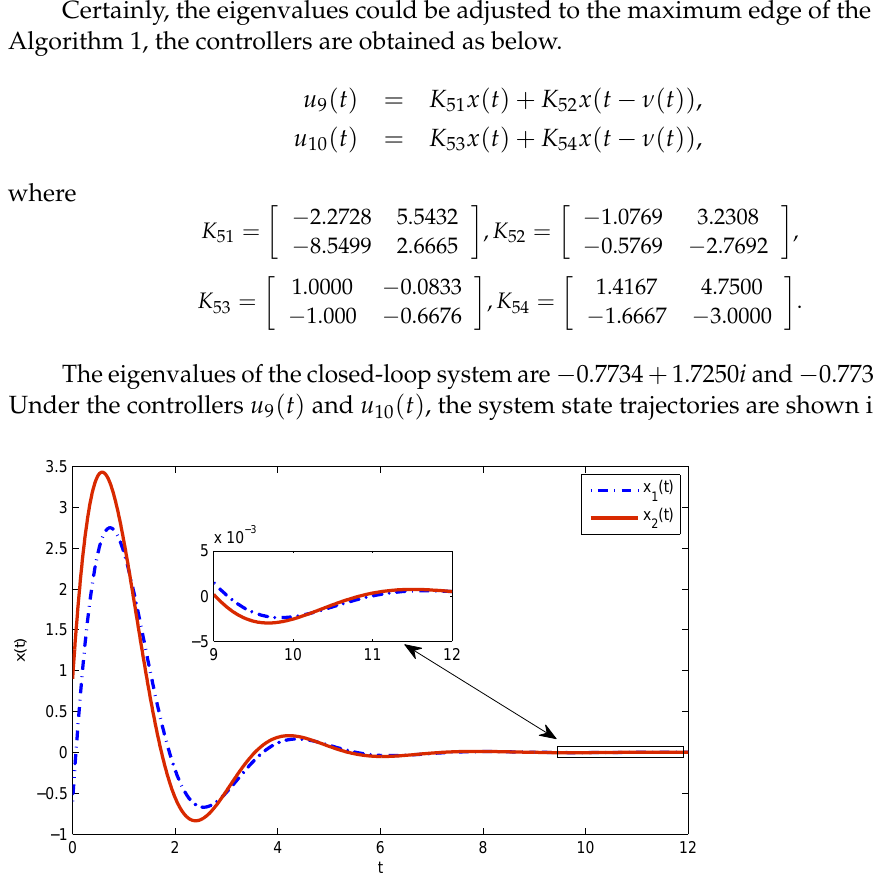
Figure 7. The state trajectories under controllers u 9 ( t ) and u 10 ( t )